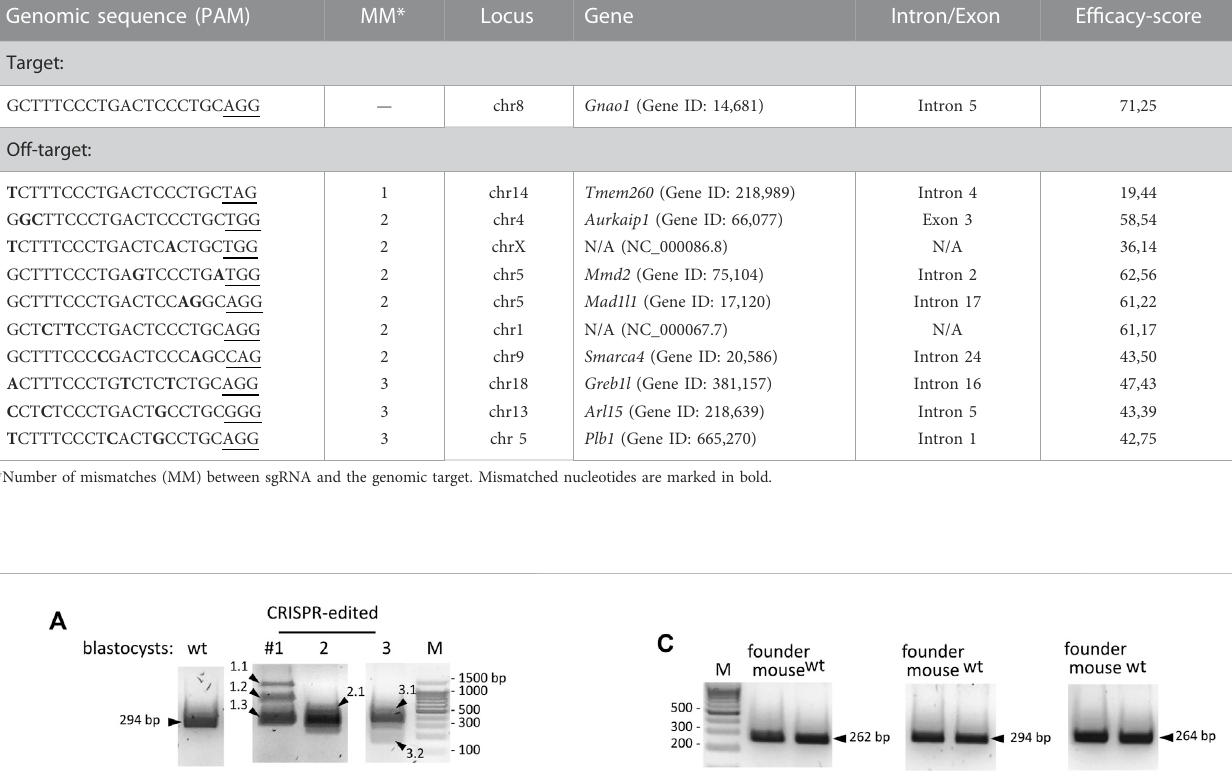
TABLE 1 Predicted off-target genome modi fi cation with sgRNA directed to Gnao1 . Genomic sequence (PAM)